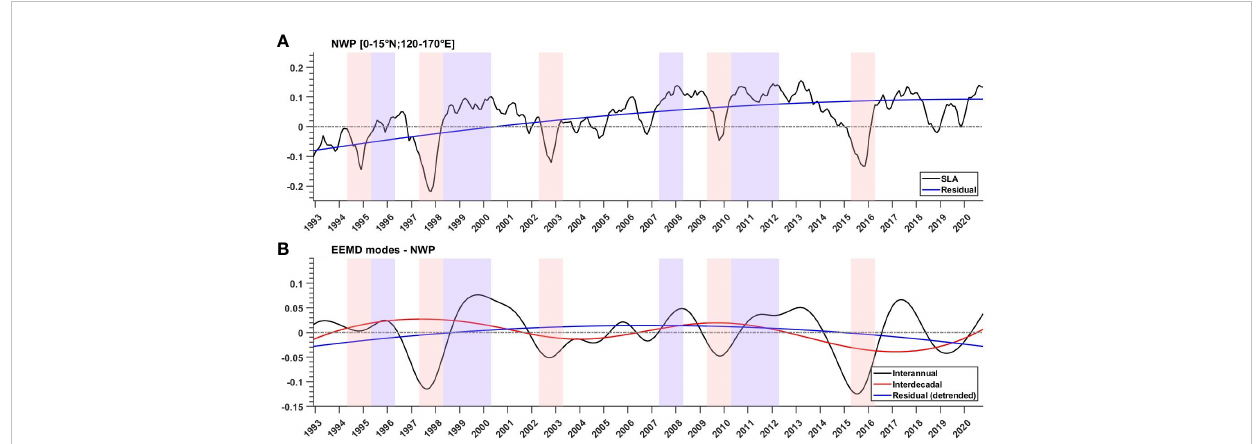
FIGURE 3 The time series shows the averaged SLA over the NWP (0 – 15 ° N; 120E ° − 170 ° E) region for the period 1993 – 2020. (A) Time series of SLA, the residual; (B) EEMD modes such interannual and interdecadal time series and detrended residual. The light color shades of rectangular boxes indicate La Niña (light blue) and El Niño (light pink)